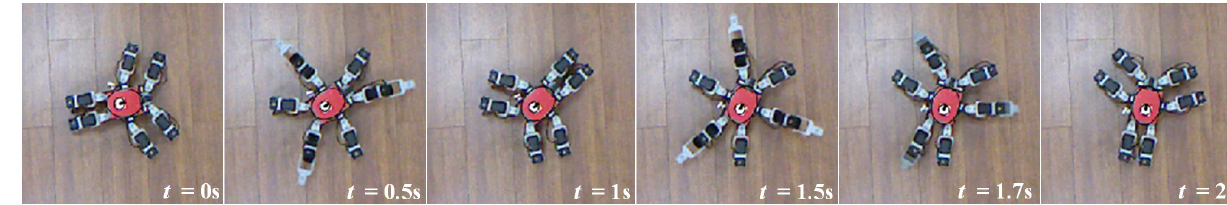
Figure 16. The experimental screenshots of the tripod gait.